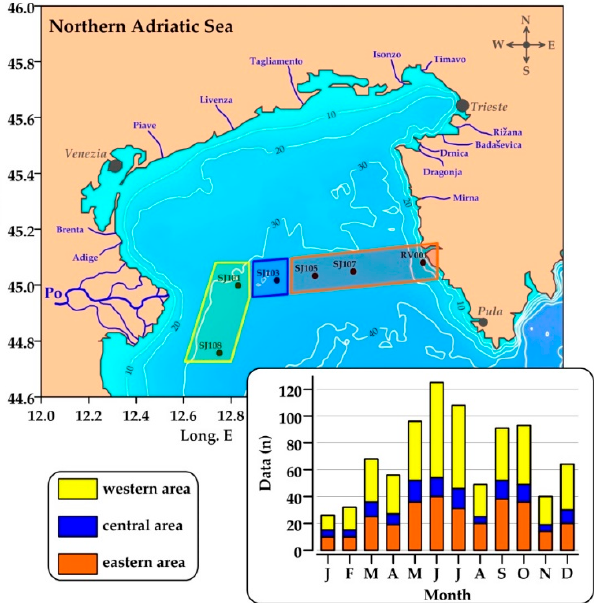
Figure 1. Sampling stations in the Northern Adriatic and definition of the three sub ‐ areas with distinct oceanographic characteristics. Major rivers in the region [21] and monthly distribution of APA data in the dataset are also shown.